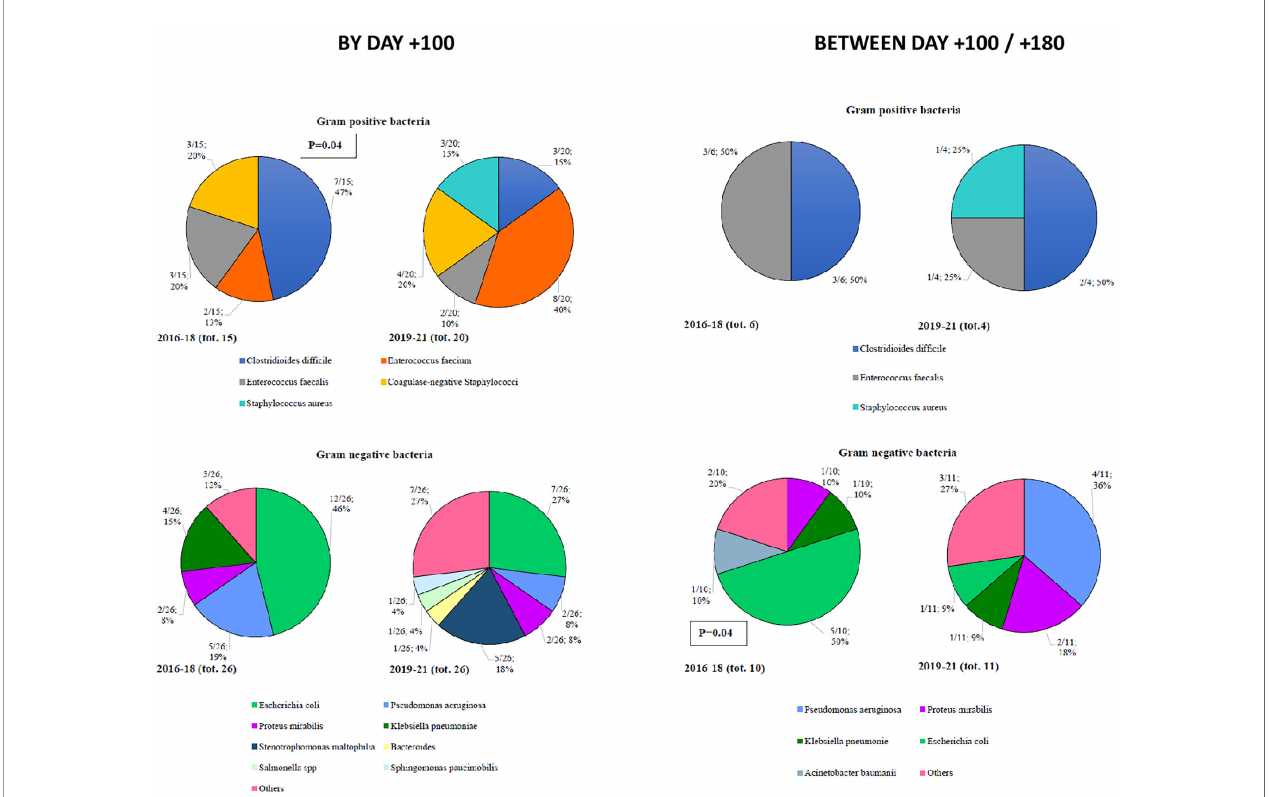
FIGURE 2 | Bacterial isolates in infectious complications with organ localization after allo-SCT.